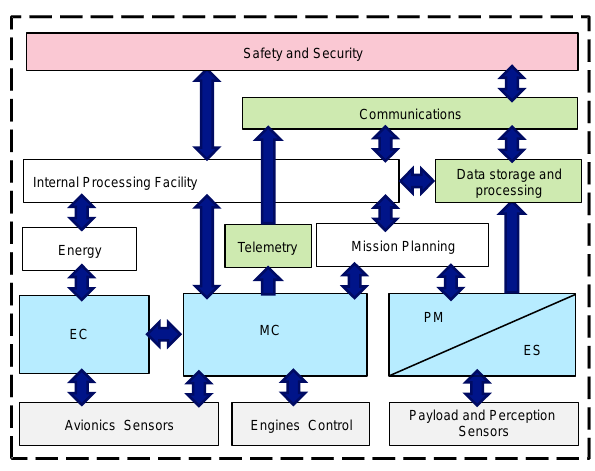
Figure 2: Main component architecture